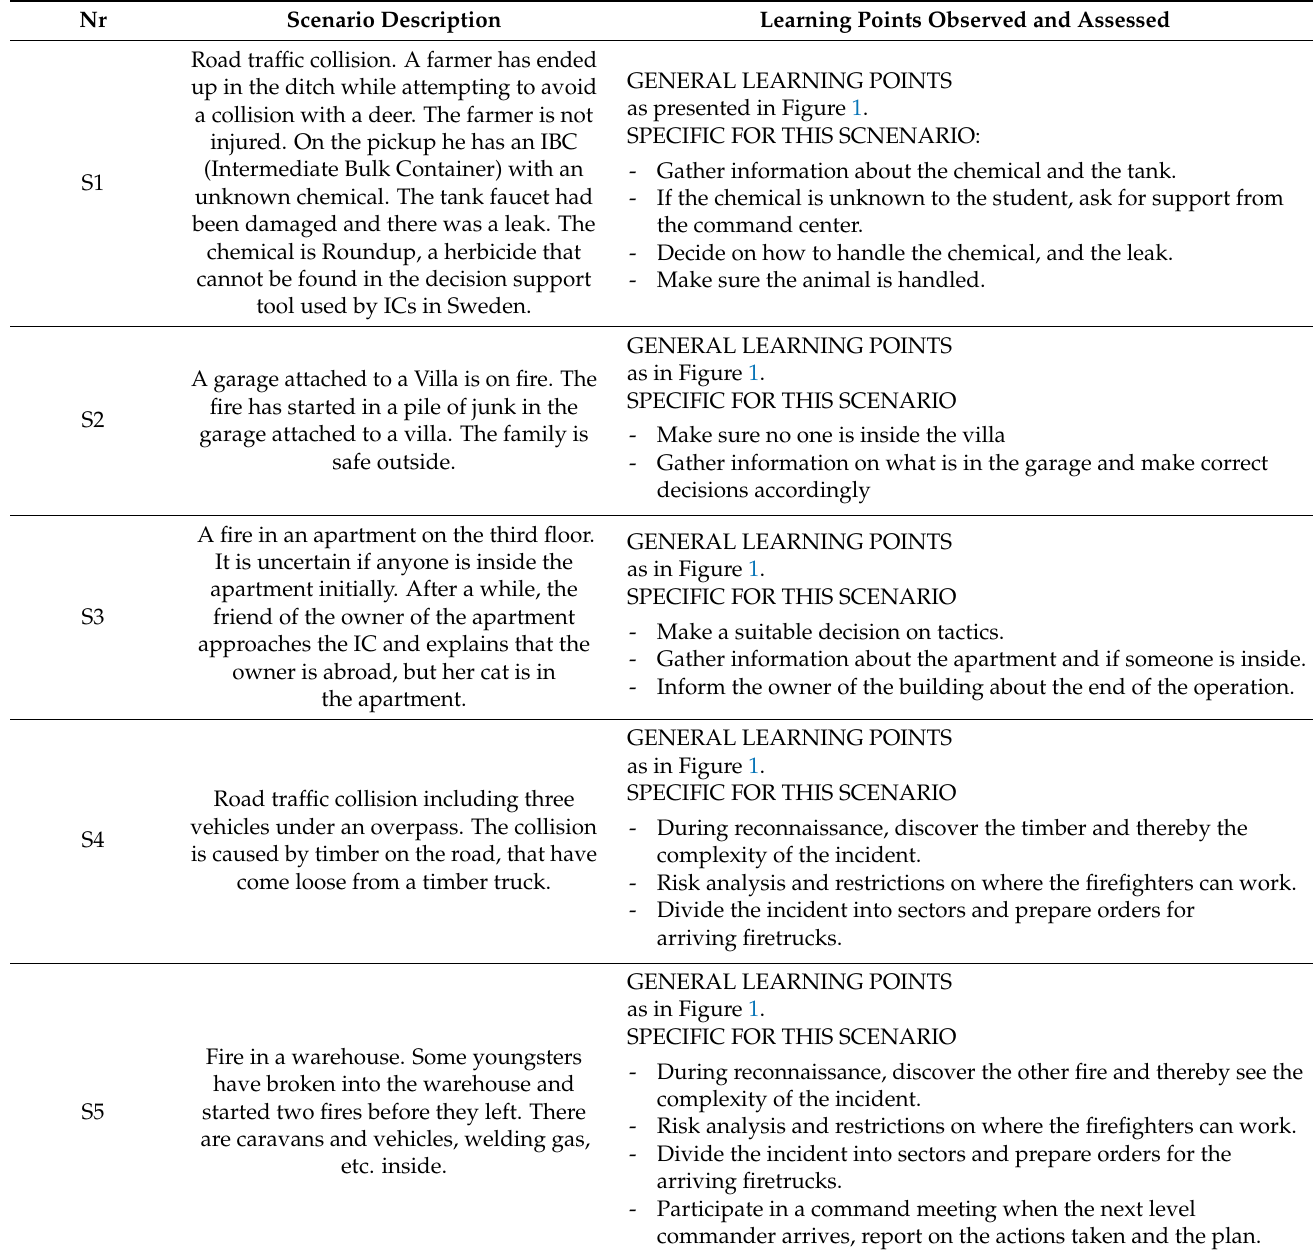
Table 2. The scenarios used during the RSV